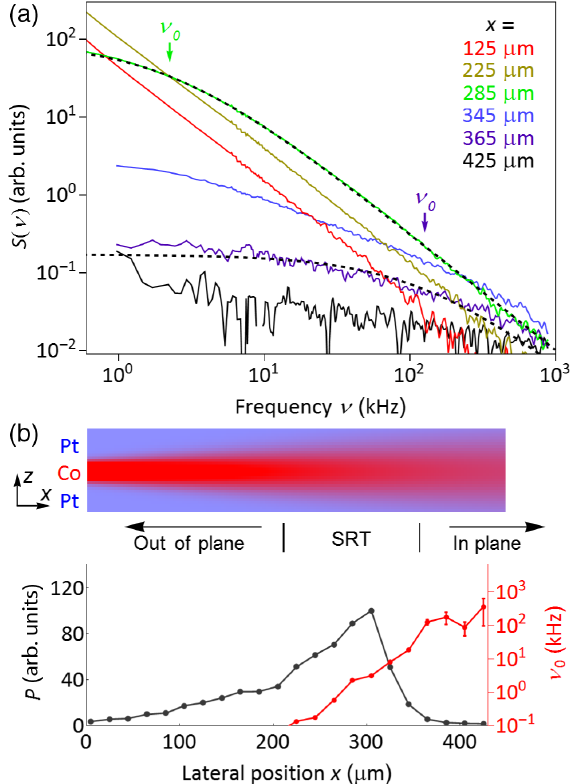
FIG. 2. (a) Power spectra of the magnetization fluctuations S ð ν Þ at different lateral positions x on the Pt = Co = Pt trilayer. In regions with perpendicular magnetization, S ð ν Þ ∝ ν − 3 = 2 . Upon entering and traversing the SRT region, S ð ν Þ develops a steadily increasing critical frequency ν 0 , below which the noise tends toward spectrally flat, consistent with an evolving low-frequency cutoff in the distribution of fluctuation rates. Empirically, all spectra can be fit by S ð ν Þ ∝ ð ν þ ν 0 Þ − 3 = 2 (dashed lines). (b) The integrated R S ð ν Þ d ν , exhibits a peak in the SRT region. noise power, P ¼ Concomitantly, ν 0 rapidly increases through the measurement bandwidth (red